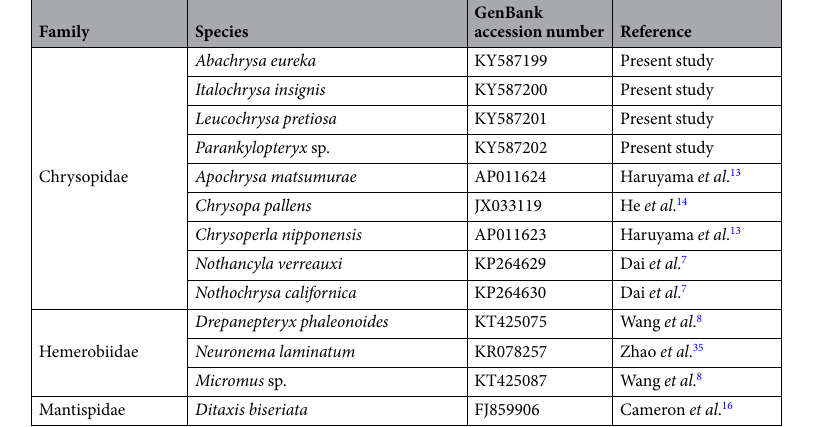
Table 1. Sampling list of the present phylogenomic analysis.